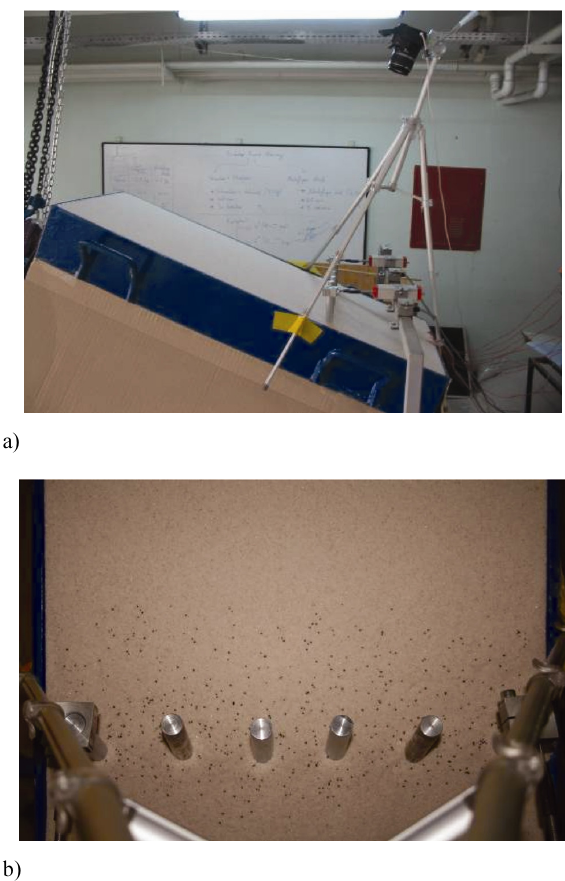
Fig. 4. Position of camera (a); Camera view (b)